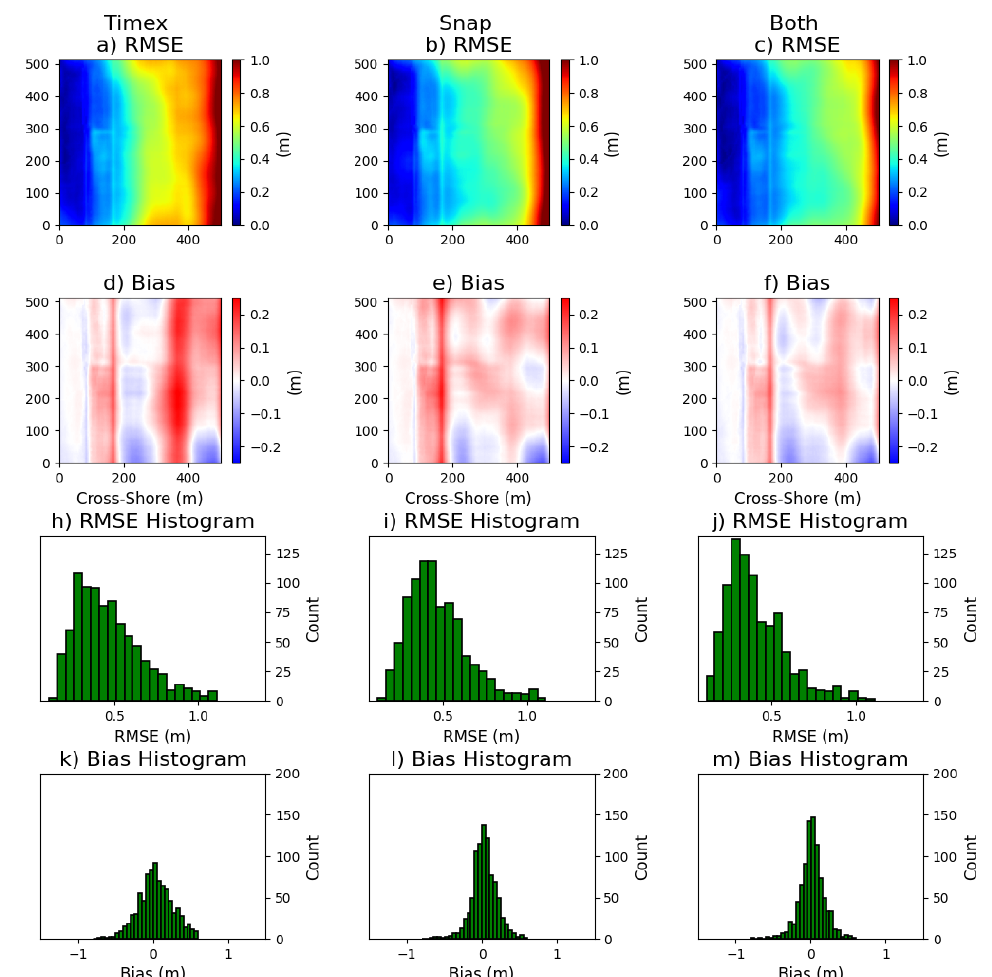
Figure 6. Spatial and image-based error for each of the three models, separated by column. The first column shows the model trained by timex only, the second column shows the model trained by snapshot only, and the third column shows the model trained with both inputs. ( a – c ) shows the 2D RMSE over the test set, ( d – f ) shows the 2D bias over the test set, ( h – j ) shows a histogram of the average RMSE for each image in the test set, and ( k – m ) shows a histogram of the average bias for each image in the test set. Each histogram has 25 bins. The second and third columns show snapshot only, the combination trained model results,